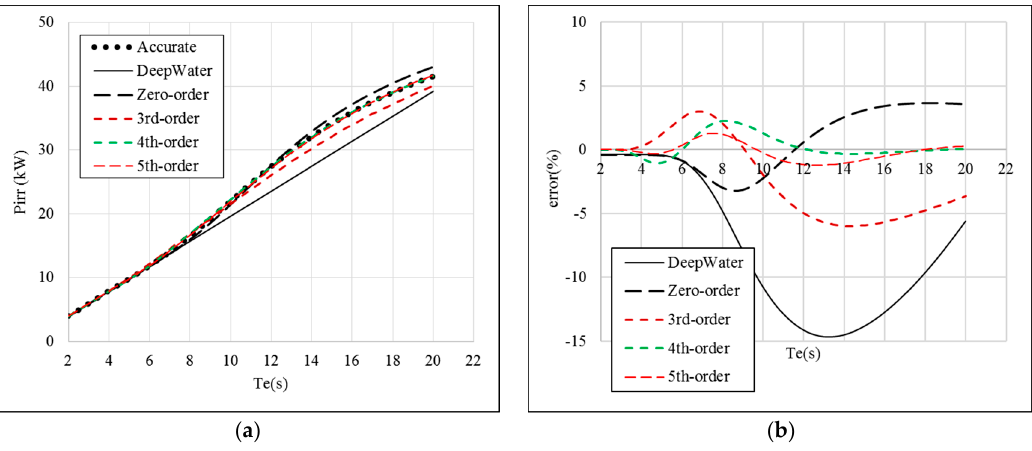
Figure 7. Comparison of the calculated wave power and the corresponding error using different methods for JONSWAP spectra of H m 0 = 2 m (water depth = 50 m). ( a ) Calculated wave power; ( b ) Error.